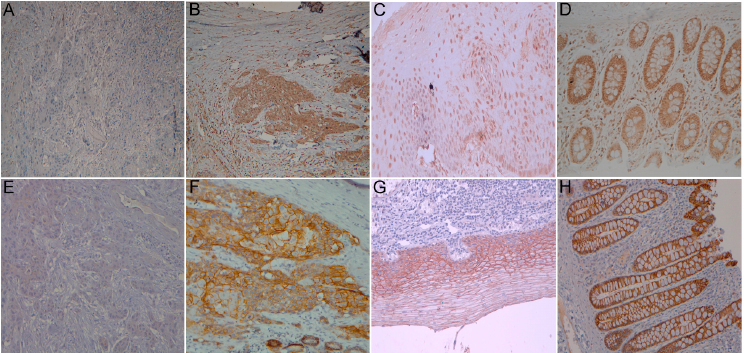
Figure 1. Immunohistochemical staining of UTX in esophageal squamous cell carcinoma (ESCC). ( A )